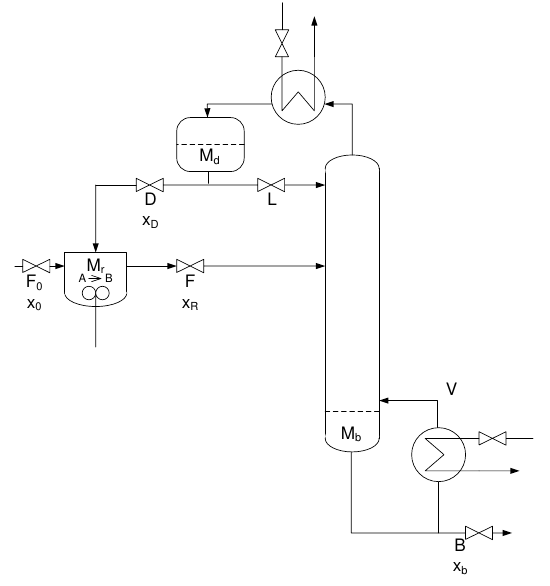
Figure 2: Diagram of reactor-separator-recycle plant.